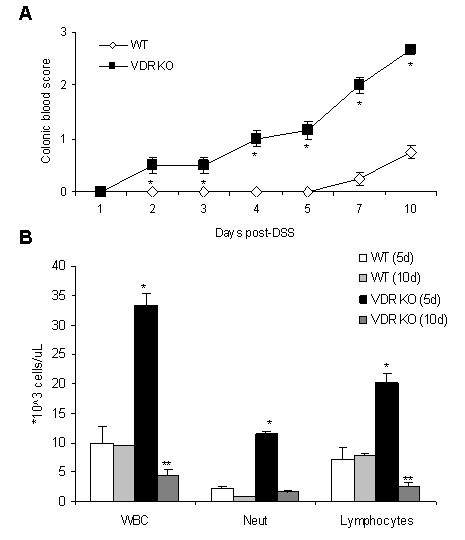
VDR KO mice have blood in the colon and altered white blood cell values compared to WT mice. A) Colonic blood score as a function of time post-DSS. Two WT and 2 VDR KO mice were sacrificed each day after 2.5% DSS administration and colonic blood score was assessed as described in the Materials and Methods. B) Hematological changes in WT and VDR KO mice following 2.5% DSS administration. Error bars represent ± SEM. * WT and VDR KO values were significantly different.